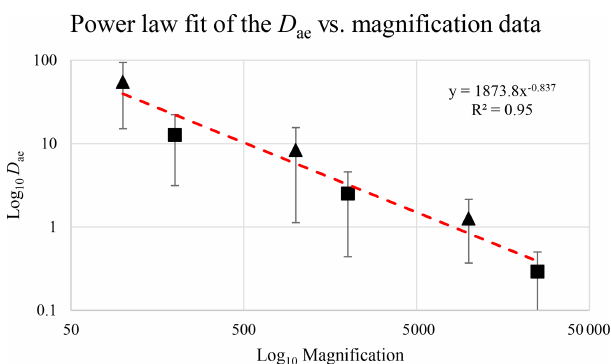
Figure 18. Average D ae at different magnifications for actinolite– tremolite (triangles; from Vigliaturo et al., 2018) and glaucophane (squares; this paper). The dashed red line shows the power-law